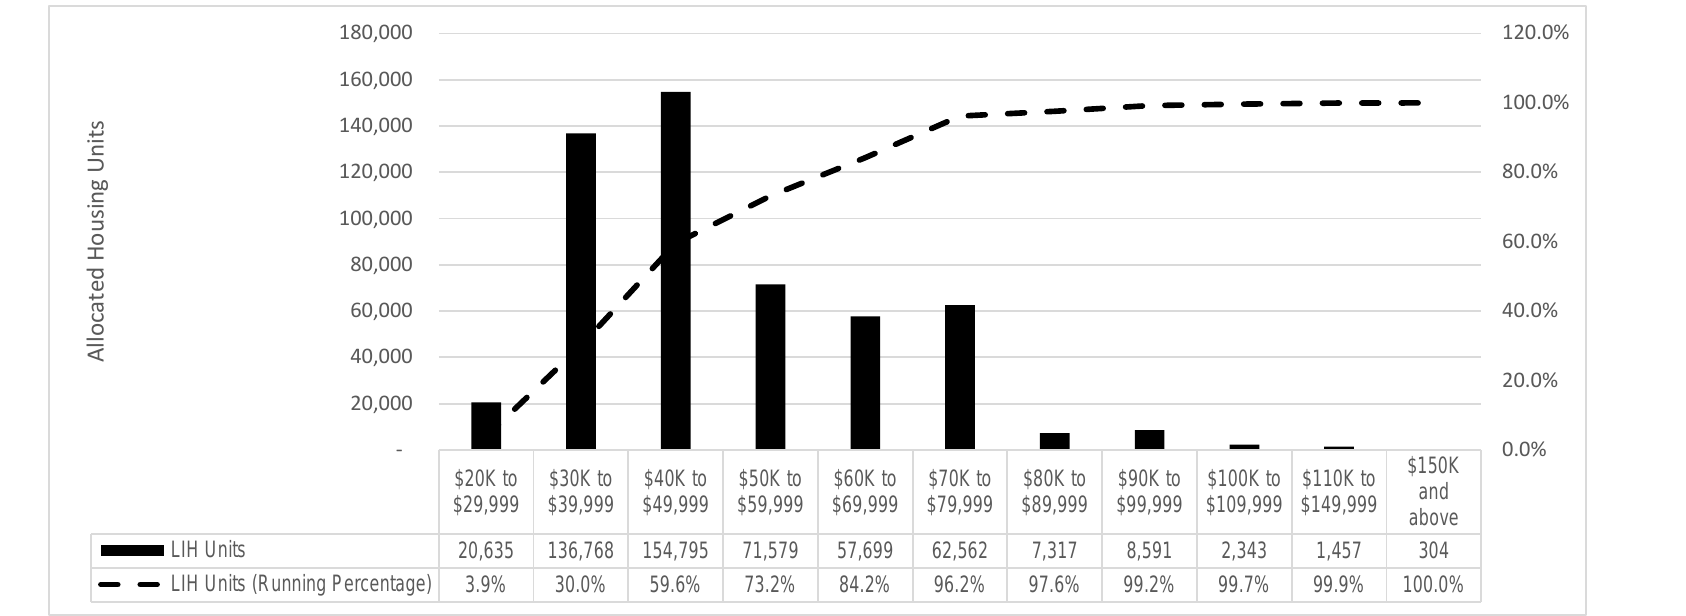
Figure 1. Distribution of the collective low-income housing needs allocations for the urban regions (i.e., Los Angeles, Sacramento, San Diego, and Sacramento; 2007–2014) and categorized by each city’s year 2000 median household income (MHI). This table indicates that cities with MHIs between $20,000–49,999 received 59.6% (or 312,198/524,050) of allocated low-income housing needs, whereas cities with MHIs higher than $70,000 received roughly 16% (or 82,574/524,050) of allocated low-income housing needs. Sources: ABAG, SACOG, SCAG, SANDAG, U.S. Census Bureau.